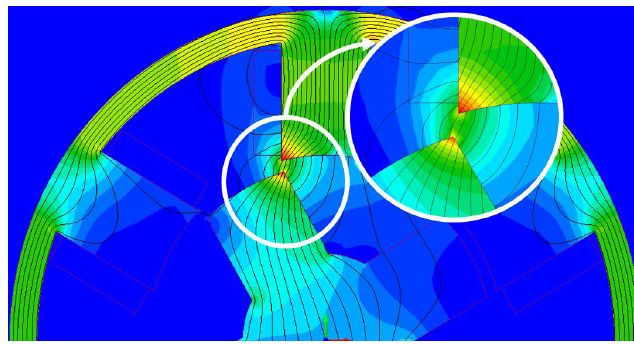
Figure 6. Fringing flux at the beginning of overlap.